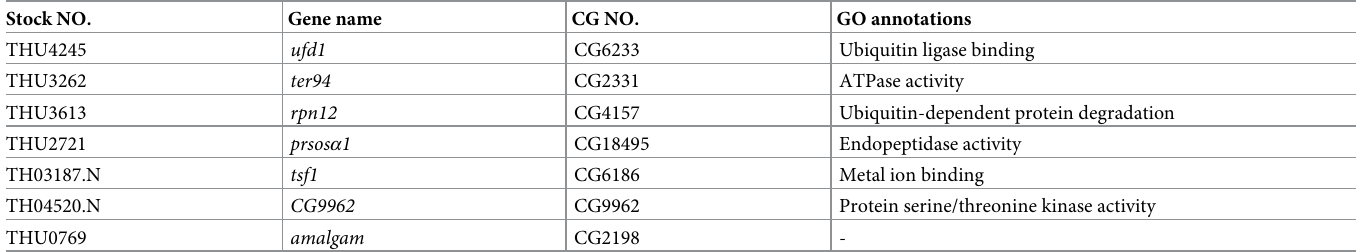
Table 1. List of genes identified in RNAi screen for factors required for SORDD1’s function. Stock